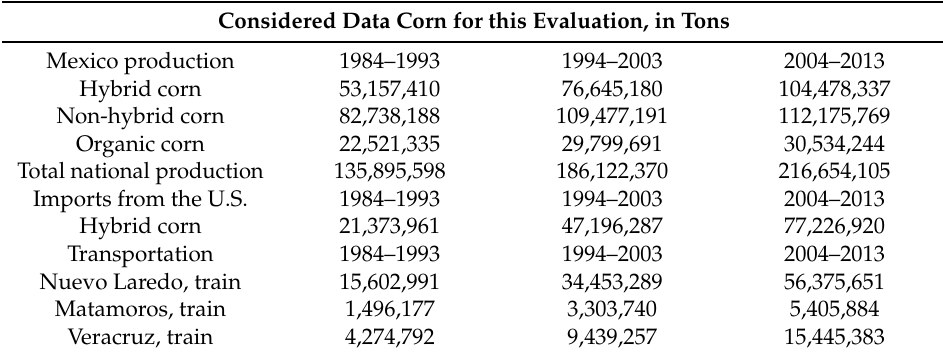
Table 2. Considered data for the impact evaluation.